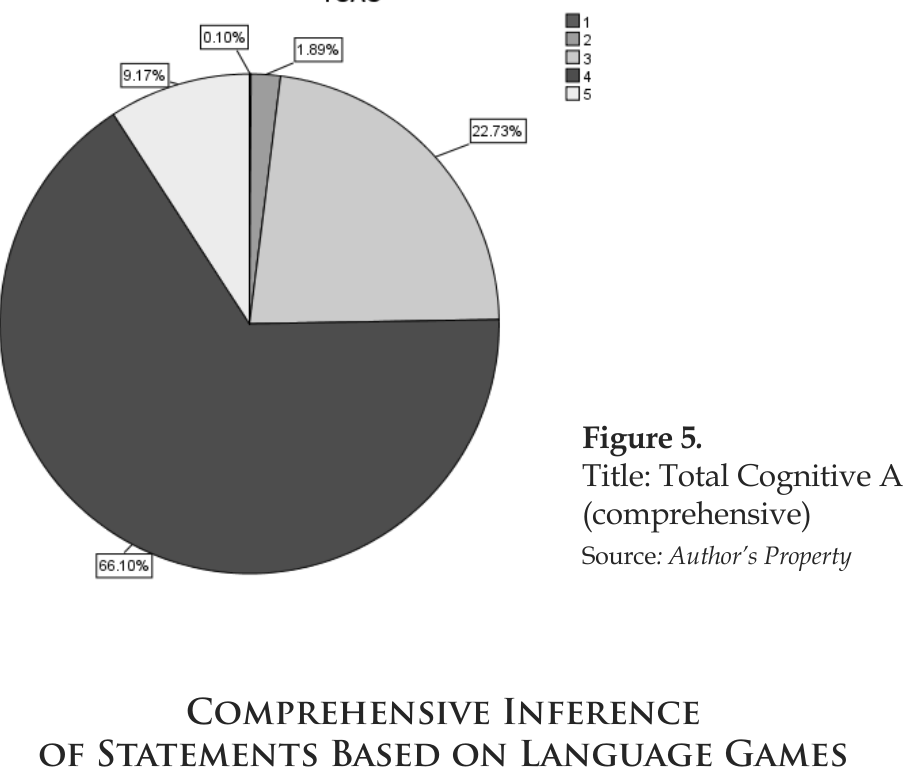
(cid:55)(cid:76)(cid:87)(cid:79)(cid:72)(cid:29)(cid:3)(cid:55)(cid:82)(cid:87)(cid:68)(cid:79)(cid:3)(cid:38)(cid:82)(cid:74)(cid:81)(cid:76)(cid:87)(cid:76)(cid:89)(cid:72)(cid:3)(cid:36)(cid:69)(cid:76)(cid:79)(cid:76)(cid:87)(cid:92)(cid:3) (cid:11)(cid:70)(cid:82)(cid:80)(cid:83)(cid:85)(cid:72)(cid:75)(cid:72)(cid:81)(cid:86)(cid:76)(cid:89)(cid:72)(cid:12) (cid:54)(cid:82)(cid:88)(cid:85)(cid:70)(cid:72) : Author’s